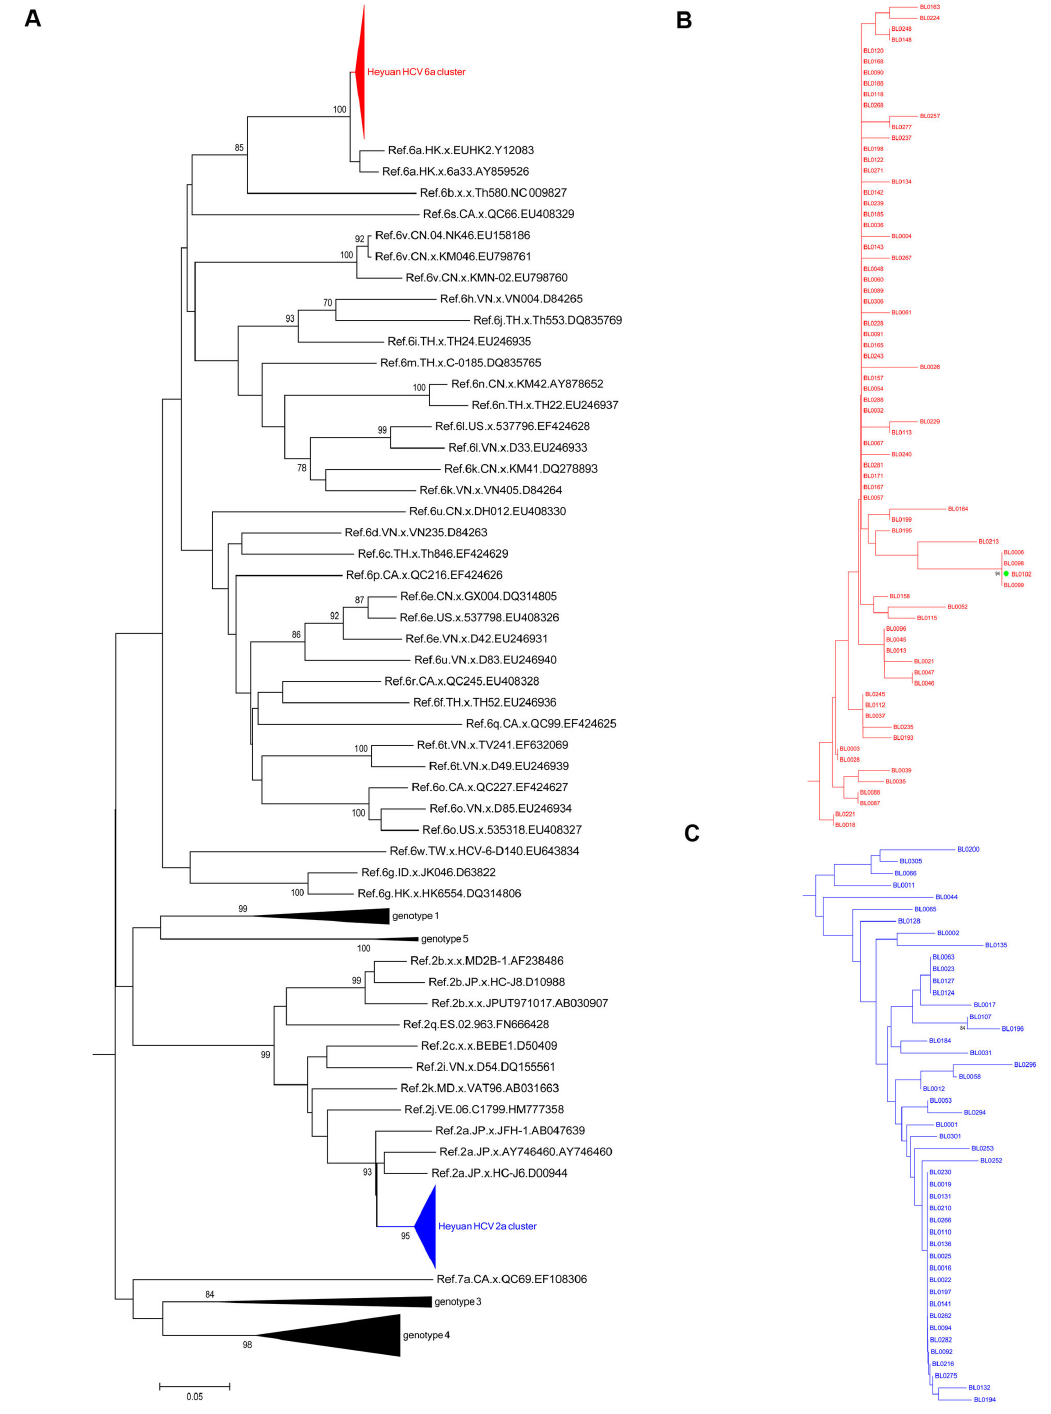
Figure 2. HCV molecular phylogenetic tree based on the NS5B sequences. The Neighbor-joining phylogenetic tree was constructed based on the NS5B gene containing 354 nucleotides, corresponding to 8268-8621 of H77 genome (NC_004102) (A). The red filled triangle indicates the 6a cluster of Heyuan HCV-infected cases; the blue filled triangle indicates the 2a cluster. Genotypes 1, 3, 4, and 5 were collapsed into black filled triangle. The subtrees of Heyuan HCV 6a cluster (B) and 2a cluster (C) display the detailed phylogenetic relations of all Heyuan HCV cases. Bootstrap values are based on 1 000 replicates and statistic values > 70% are indicated at the nodes of the corresponding branches. The scale bar unit is substitutions/site. doi: 10.1371/journal.pone.0082304.g002 PLOS ONE |